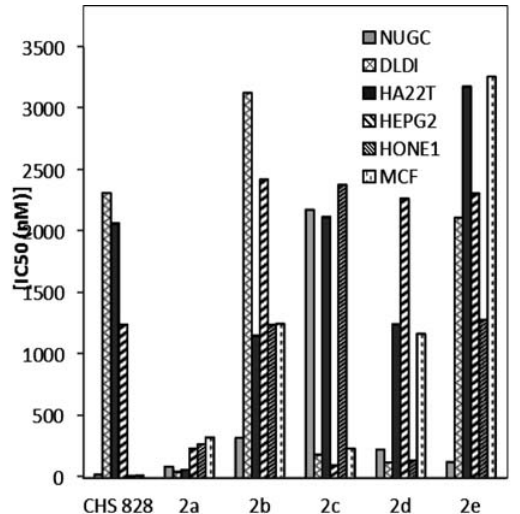
Figure 2 . Cytotoxicity of 2a – e and CHS 828 against NUGC (ga- stric cancer); DLDI (colon cancer); HA22T (liver cancer); HEPG2 (liver cancer); HONE1 (nasopharyngeal carcinoma); MCF (breast cancer).